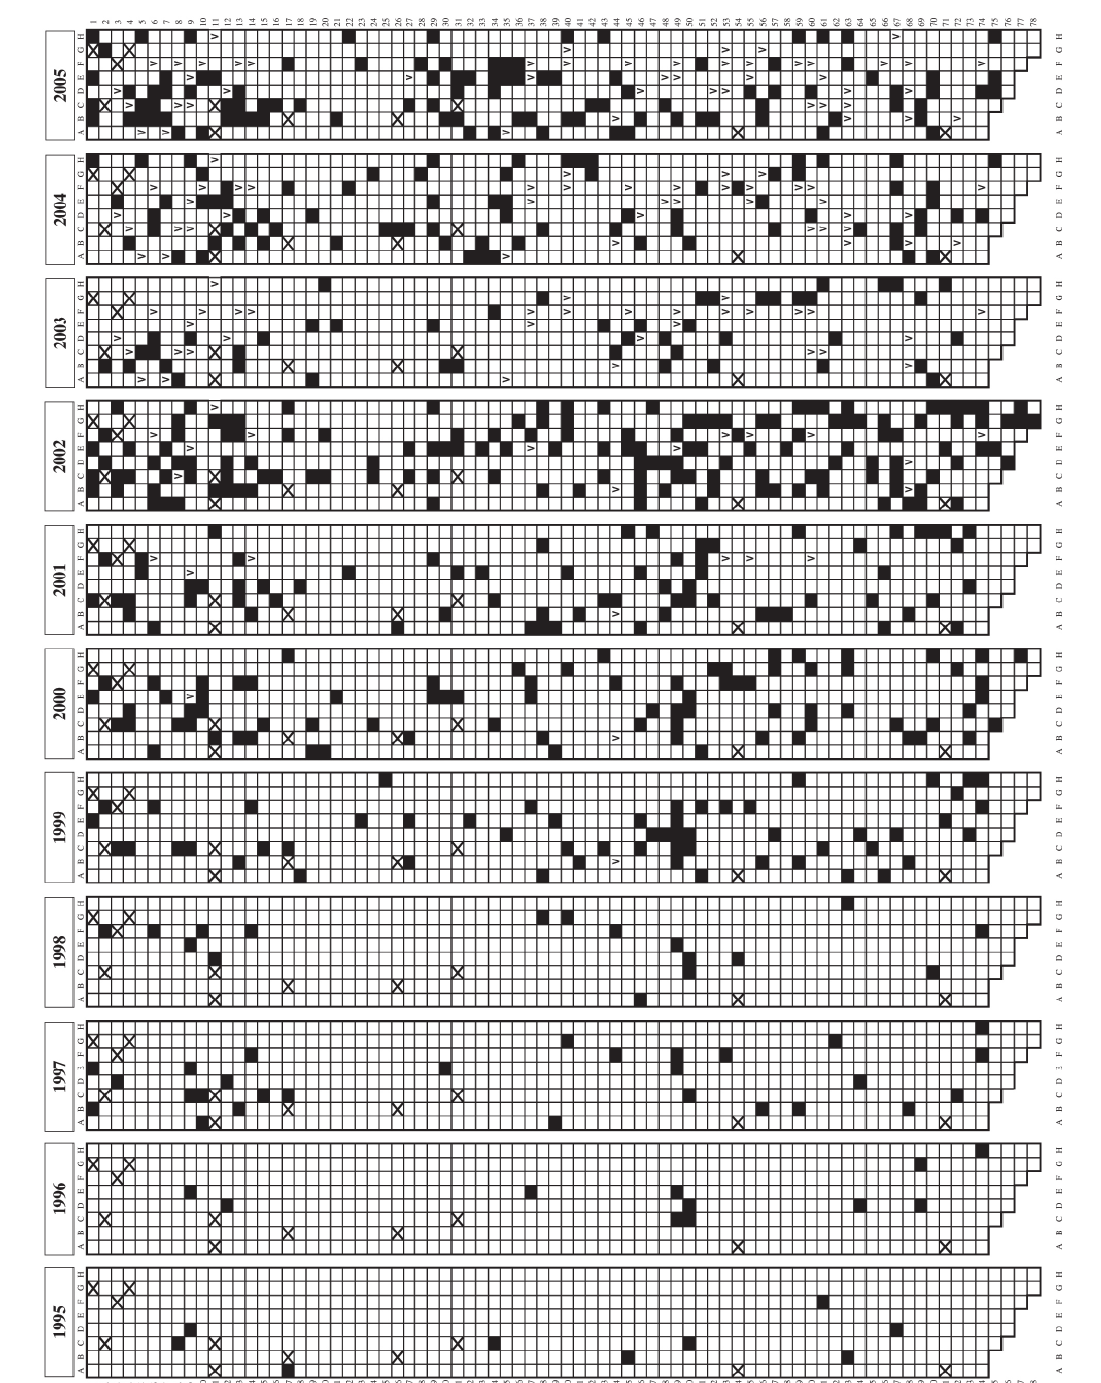
Fig. 7. Annual spatial pattern of esca-diseased plants in vineyard CBSI4 in the province of Siena. Black squares, symptomatic plants; open squares, asymptomatic plants; ‘ (cid:1) ’, plants died before start of survey (cause unknown); ‘ (cid:2) ’, plants died during survey period, with or without esca symptoms in previous